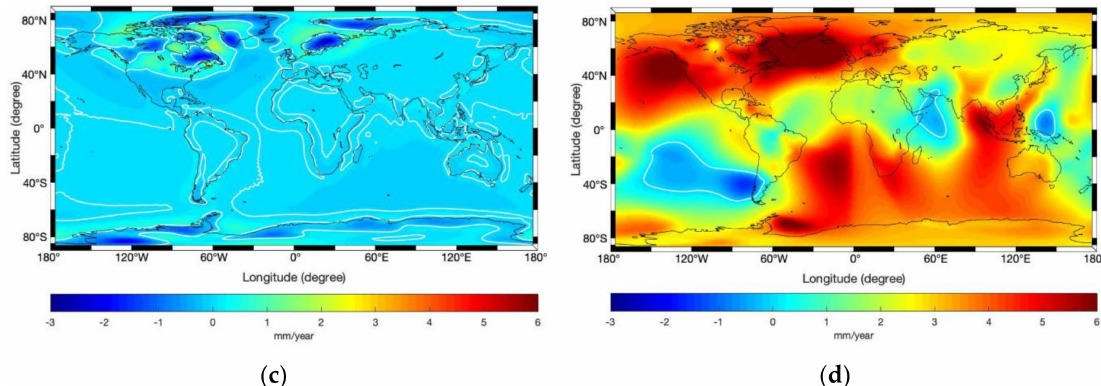
Figure 6. Di ff erences in uplift rates of ICE6GD, PUR16, PUR18, and GPSinterp with respect to the weighted average GIA model ICE6Gavg. ( a ) Di ff erence between ICE6GD and ICE6Gavg; ( b )di ff erencebetweenPUR16andICE6Gavg; ( c )di ff erencebetweenPUR18andICE6Gavg; ( d )di ff erence between GPSinterp and ICE6Gavg, where the di ff erences are reconstructed using spherical harmonic analyses. The zero-di ff erence contours are indicated by white curves. Note that strong GPSinterp signals over oceans are not realistic, thus only its signals on land make sense and will be